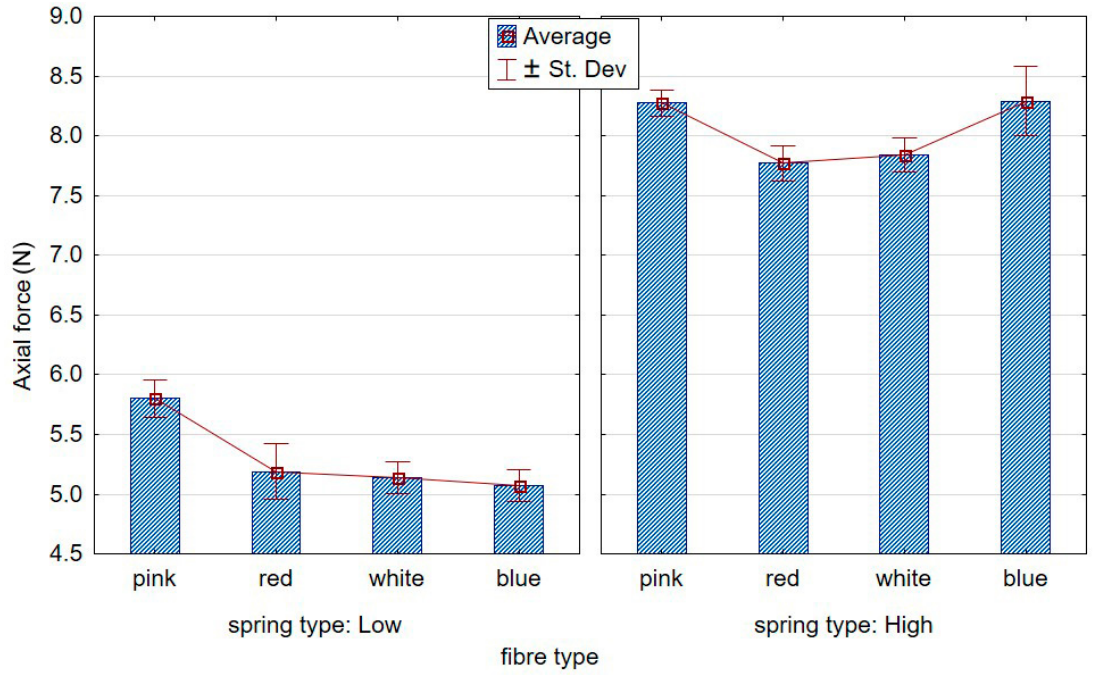
Figure 10. Effect of the fibre type on the axial force in the stable cutting zone for the two tested springs.